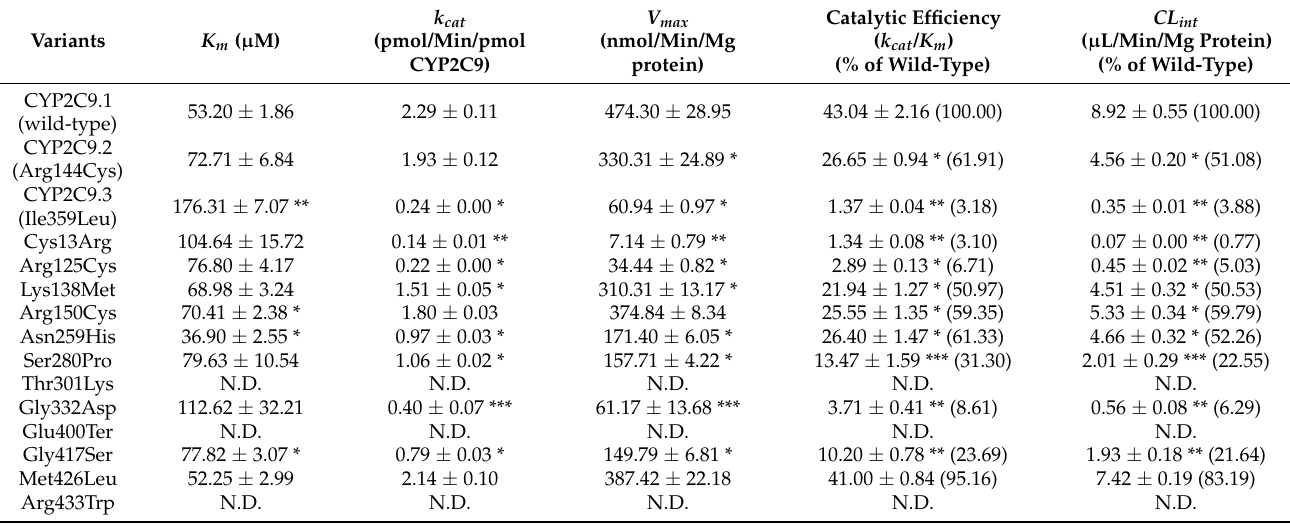
Table 4. Kinetic parameters of tolbutamide 4-hydroxylation by microsomes from 293FT cells expressing wild-type and variant CYP2C9